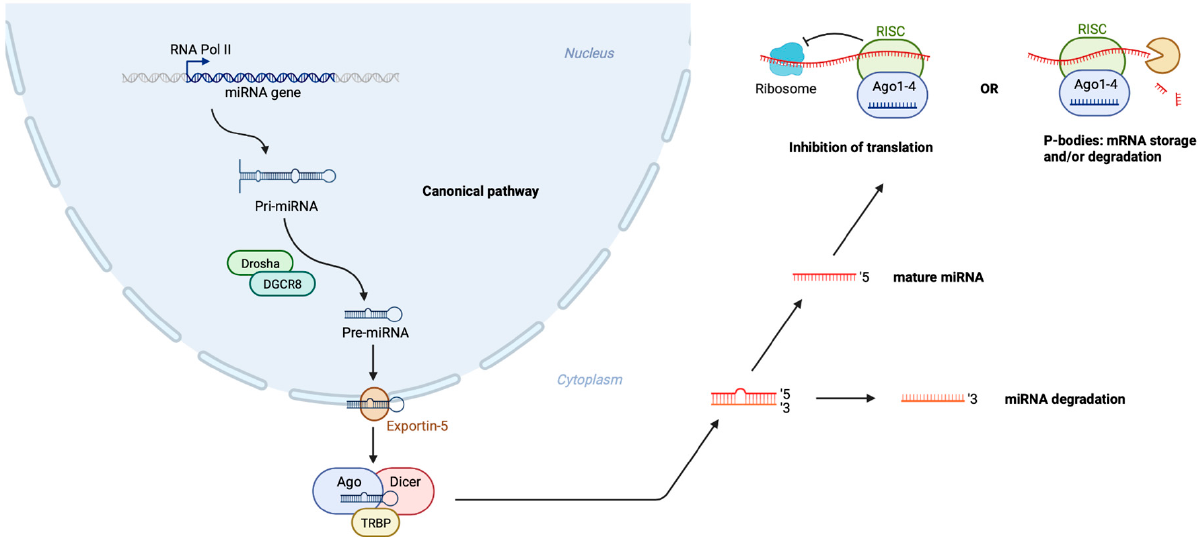
Figure 1. Schematic representation of miRNA biogenesis and mechanism of action. RNA polymerase II transcribes miRNA genes into primary miRNA (pri-miRNA) in the cellular nucleus. The enzyme, Drosha process pri-miRNA into precursor miRNA (pre-miRNA), which is exported out to the cytoplasm by exportin 5. In the cytoplasm the pre-miRNA is processed into a double-stranded miRNA/miRNA*duplex by Dicer. Two mature miRNA species may be generated from the 5 ′ and 3 ′ arms of the duplex (referred to as 5p and 3p), however in most cases one is degraded and the other dominates. The mature miRNA is incorporated into RISC (RNA inducing silencing complex). The RISC with bound miRNA, then binds to target mRNA, triggering degradation or inhibition of